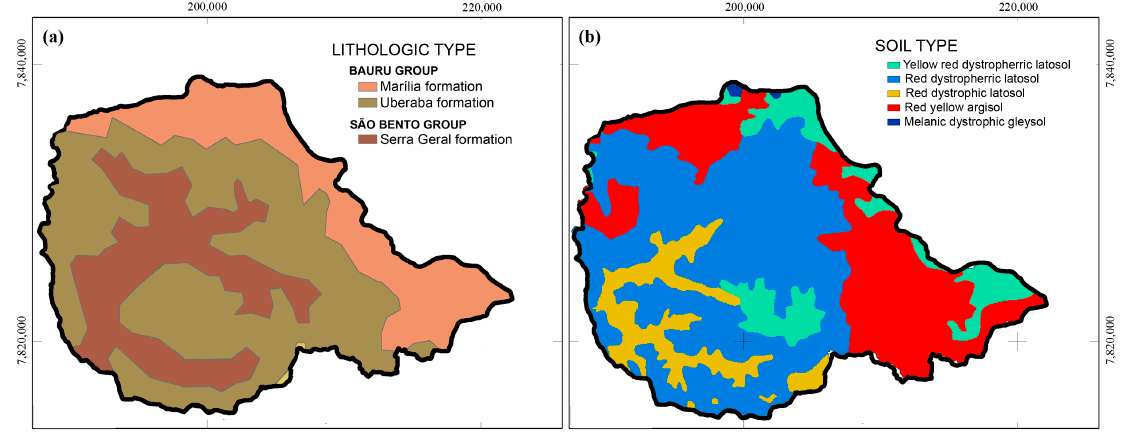
Figure 2. Geology ( a ) and soils ( b ) in the Environmental Protection Area of Uberaba River Basin. The soil map was adapted from Siqueira et al. [44].